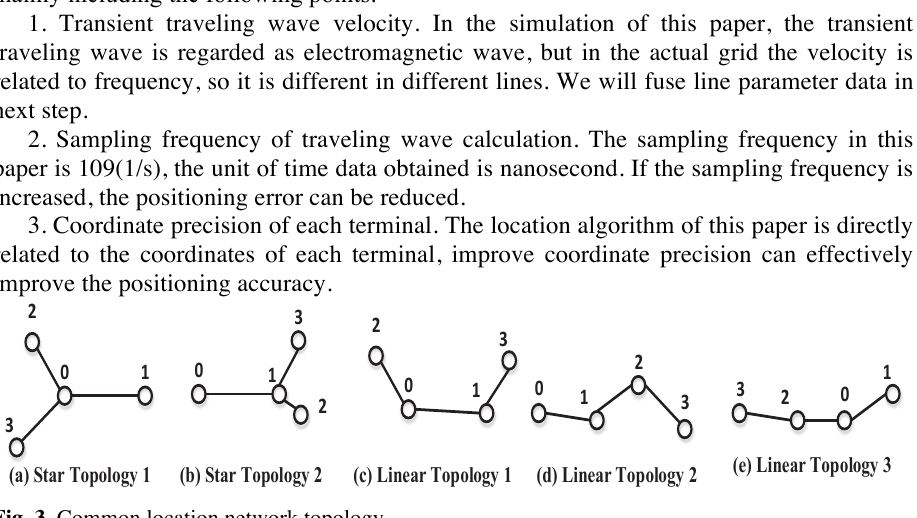
Fig.2. Simulation mold of power grid